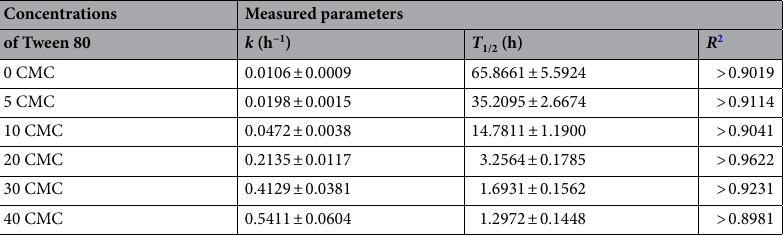
Table 1. The pseudo-first order kinetic parameters of ANT conversion by LMS-HOBt. Experimental apparent pseudo-first-order kinetic parameters ( k ) and half-lives ( T 1/2 ) values determined for LMS-HOBt transformation of ANT with different Tween 80 concentrations corresponding to Fig.